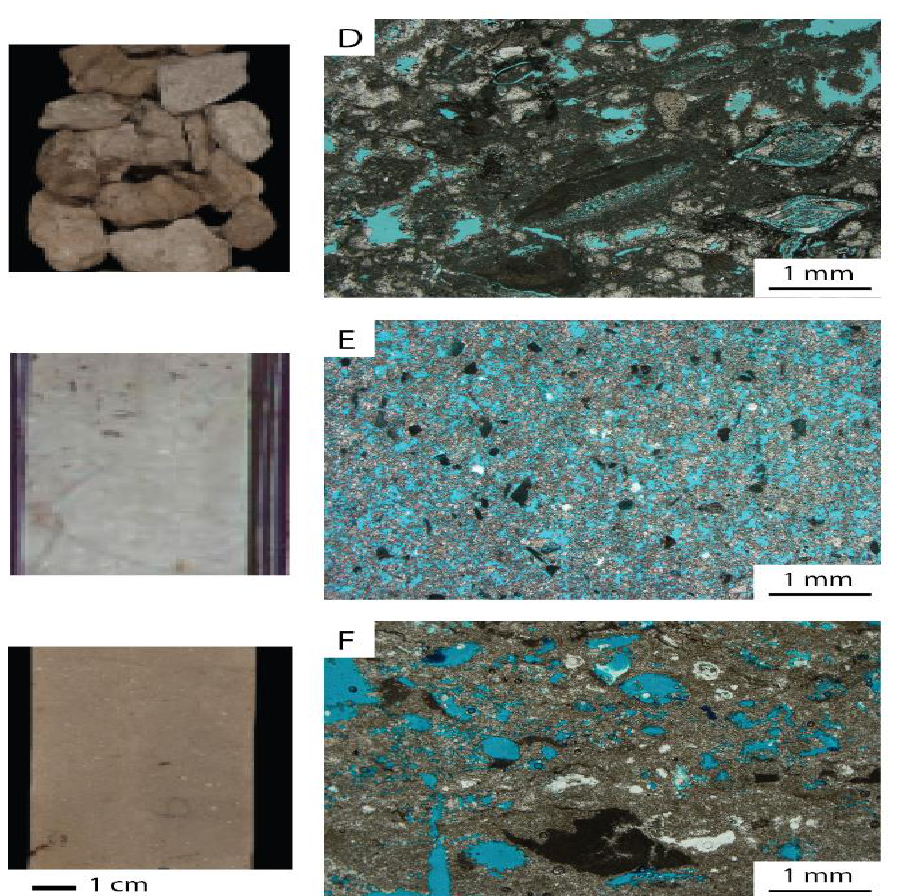
Figure 6. Core and thin sections of rock types: ( A ) dense argillaceous shale (RT1), ( B ) cemented argillaceous limestone (RT2), ( C ) mouldic limestone (RT3). ( D ) chalkified limestone (RT4), ( E ) sucrosic dolomite RT5, and ( F ) mouldic sucrosic dolomite